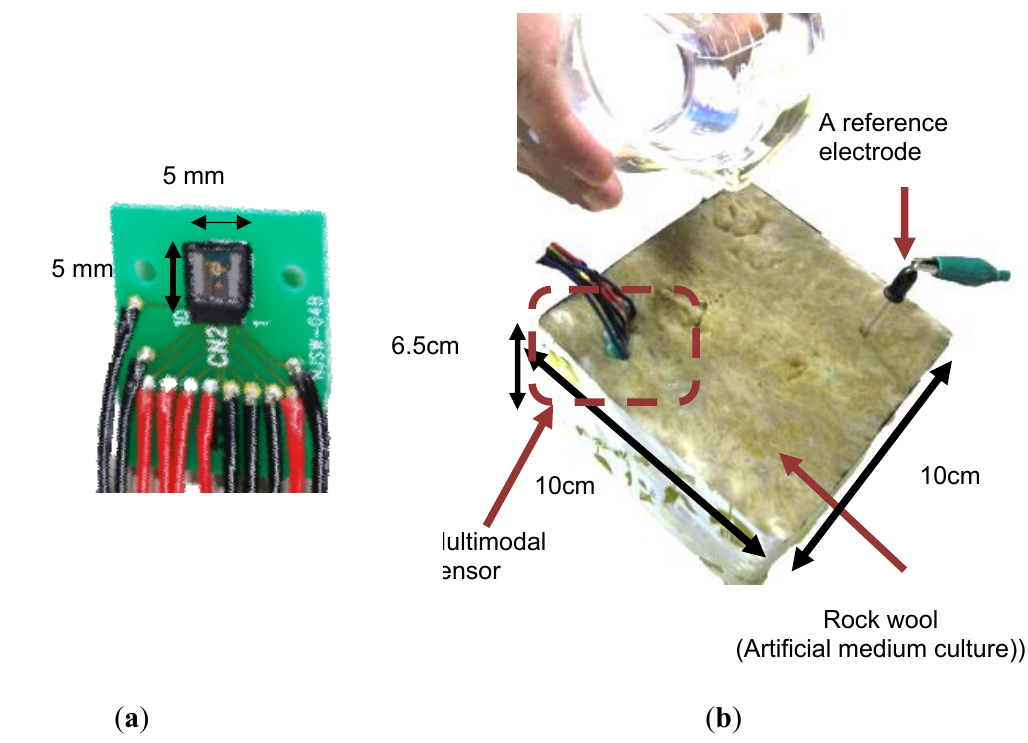
Figure 11. Photograph of the sensor chip and the experiment. ( a ) The 5 mm × 5 mm sensor chip bonded and electrically-wired to a PCB substrate. The connections between the chip and the PCB, and between the PCB and the lead wires are shielded by epoxy resin and adhesive bonds; ( b ) The sensor and the reference electrode are inserted in the rock wool. The rock wool includes a nutrient solution diluted by